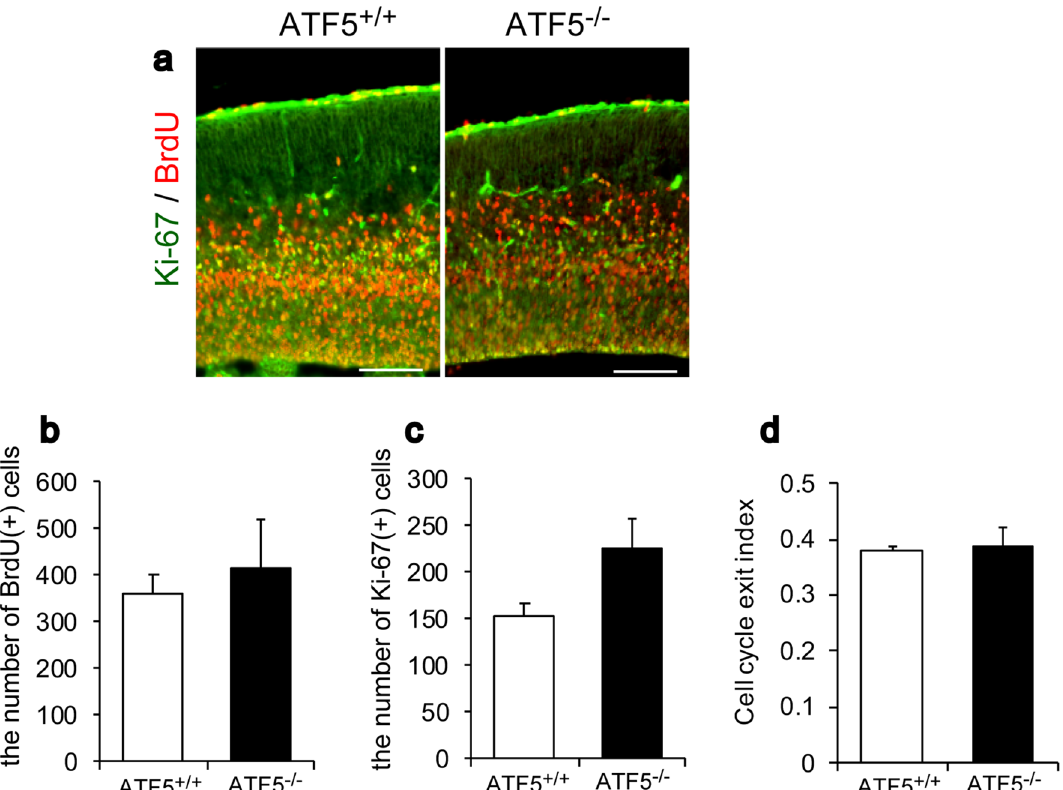
Figure 2. Analysis of proliferating cells in the developing cortices of ATF5 −/− mice. ( a ) Immunostaining for Ki-67 and BrdU (markers of proliferating cells) on embryonic day 15 (E15). Pregnant mice were injected intraperitoneally with BrdU (200 mg/kg body weight) on E14 and dissected after 24 h. ( b – d ) Quantification of the numbers of BrdU-positive cells ( b ) and Ki-67-positive cells ( c ), and the cell cycle exit index ( d , BrdU( +) Ki-67( −) / all BrdU ( +) cells) on E15. Data are presented as mean ± S.E.M. ( n = 3 mice per group). Scale bars represent 50